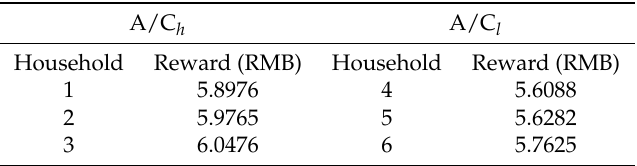
Table 10. Reward of each